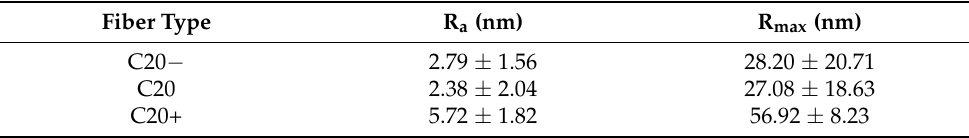
Table 5. Advancing contact angle of the PP fibers in pure water (Wilhelmy method).